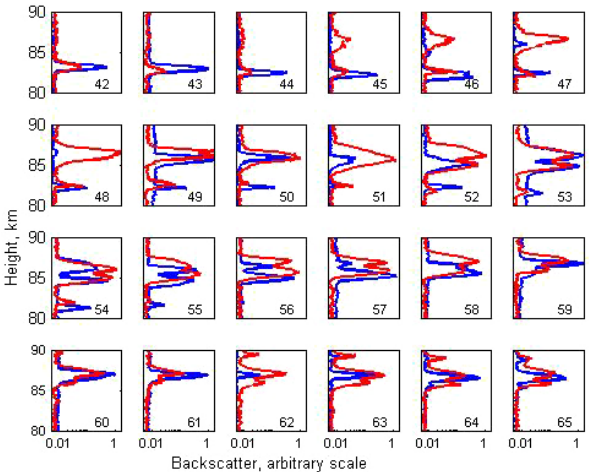
Figure 2. Vertical profiles of PMSEs for cycles 42 to 65 for the MORRO and VHF radars. The plotted profiles for each cycle corre- spond to the backscatter averaged over 10s just before the heater is switched on. MORRO profiles are red; VHF profiles are blue. The cycle numbers are shown in the lower right-hand